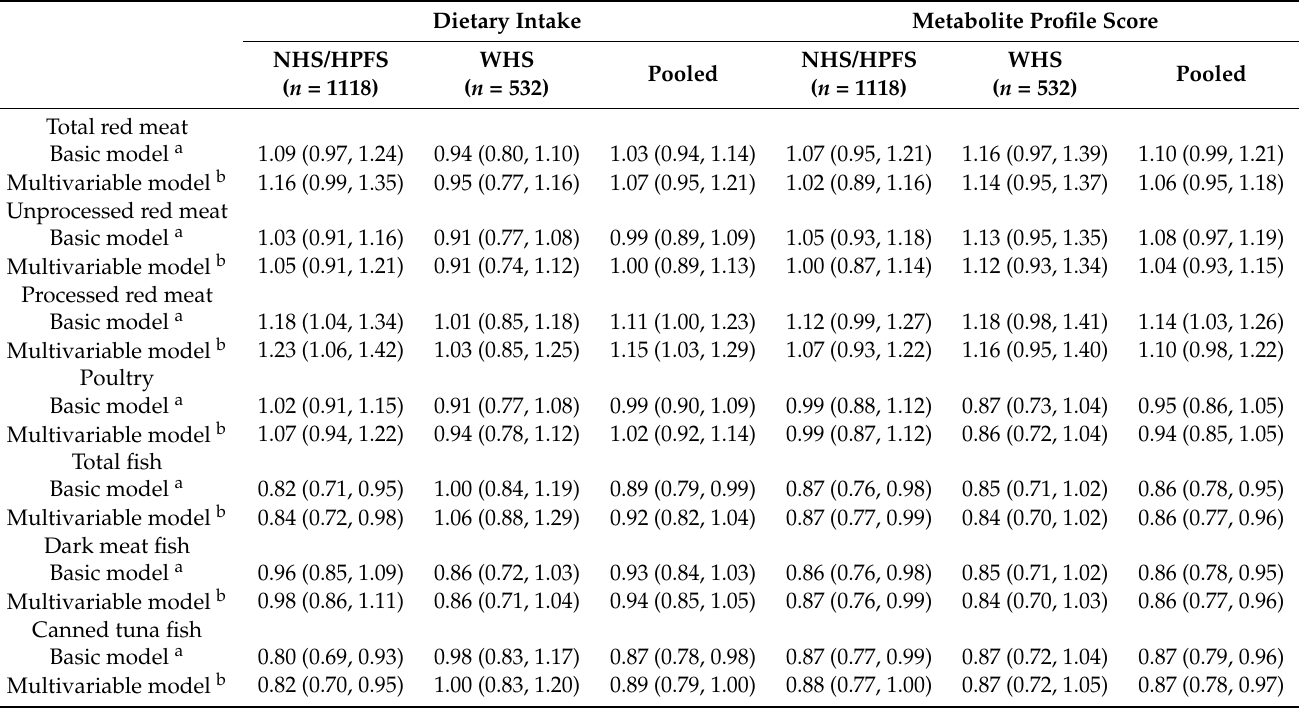
Table 3. Associations of meat and fish intake and the corresponding metabolite profile score with CRC